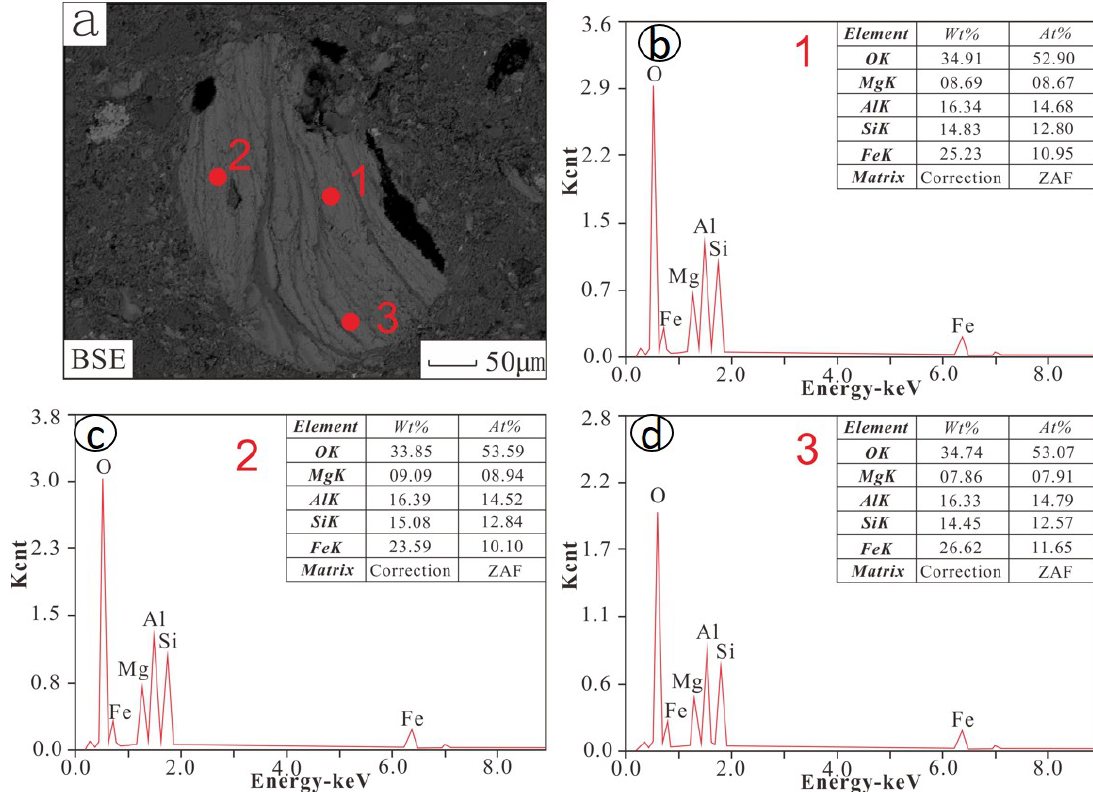
Figure 4. ( a – d ) Chlorite EDAX micro ‐ area energy spectrum analysis.